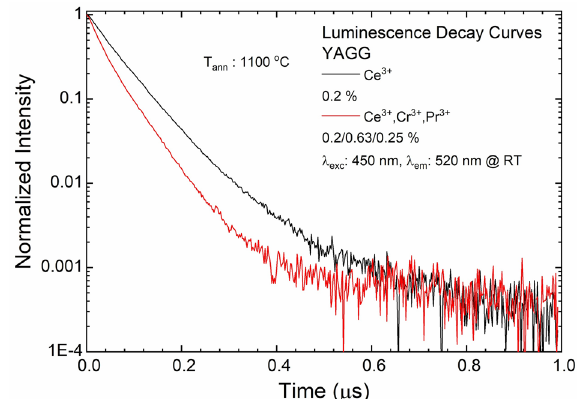
Figure 6. The luminescence decay curves of YAGG:Ce 3+ and YAGG:Ce 3+ ,Cr 3+ ,Pr 3+ nanophosphors annealed at 1100 °C. λ exc : 450 nm and λ em : 520 nm at